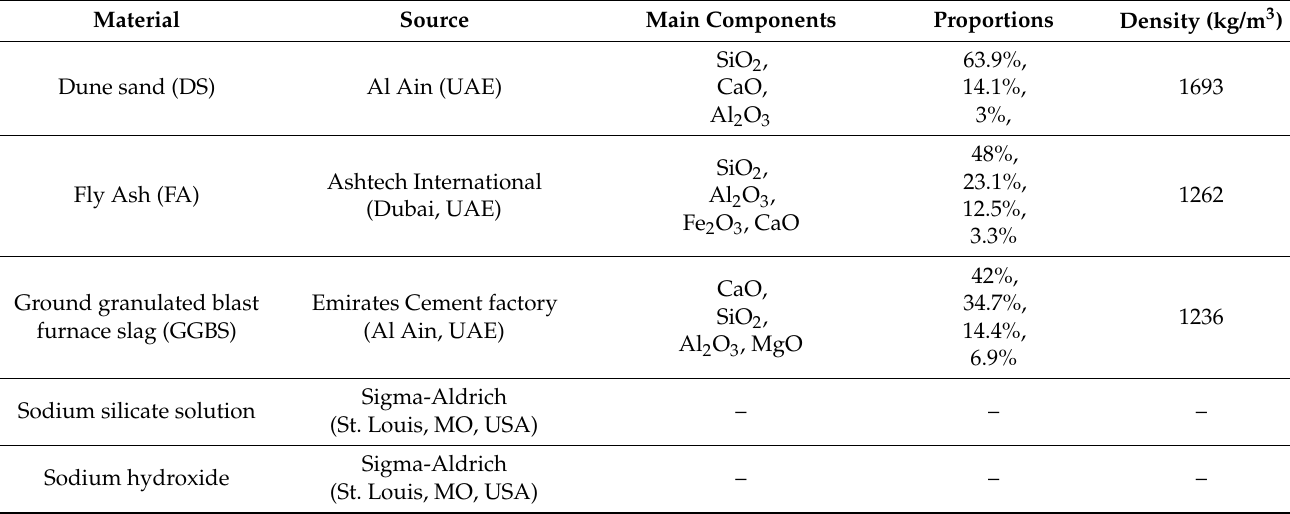
Figure 1. Photographs of the raw materials and the process of development of the samples. Table 1. Material properties with procurement sources used in the development of specimens.